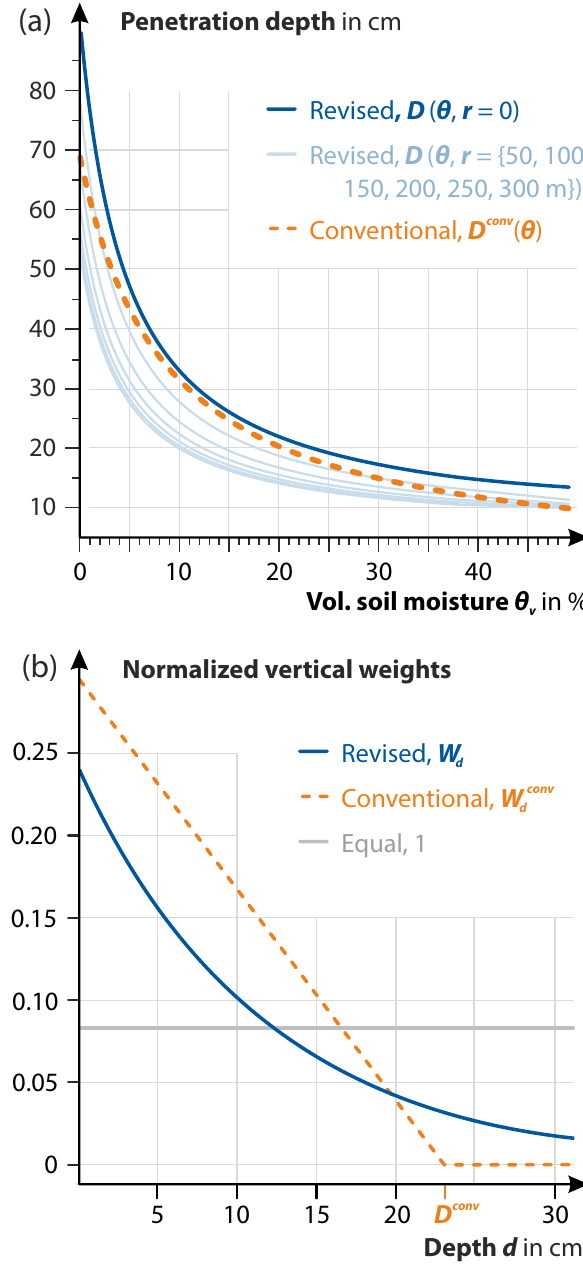
Figure 1. (a) A comparison between the revised and the conven- tional penetration depths, D(θ , r , (cid:37) bulk = 1.4gm − 3 ) and D conv (θ) , respectively. On average, both approaches follow an almost sim- ilar shape; however, the conventional formulation is independent of distance r and soil bulk density (cid:37) bulk . (b) Normalized verti- cal weighting functions (Eqs. 3 and 4) based on 12 sample points. The conventional, linear approach overestimates the relative con- tribution from shallow water when compared to the revised, ex- ponential function, and neglects contributions from depths beyond D conv ≡ z ∗ ( = 23cm in this